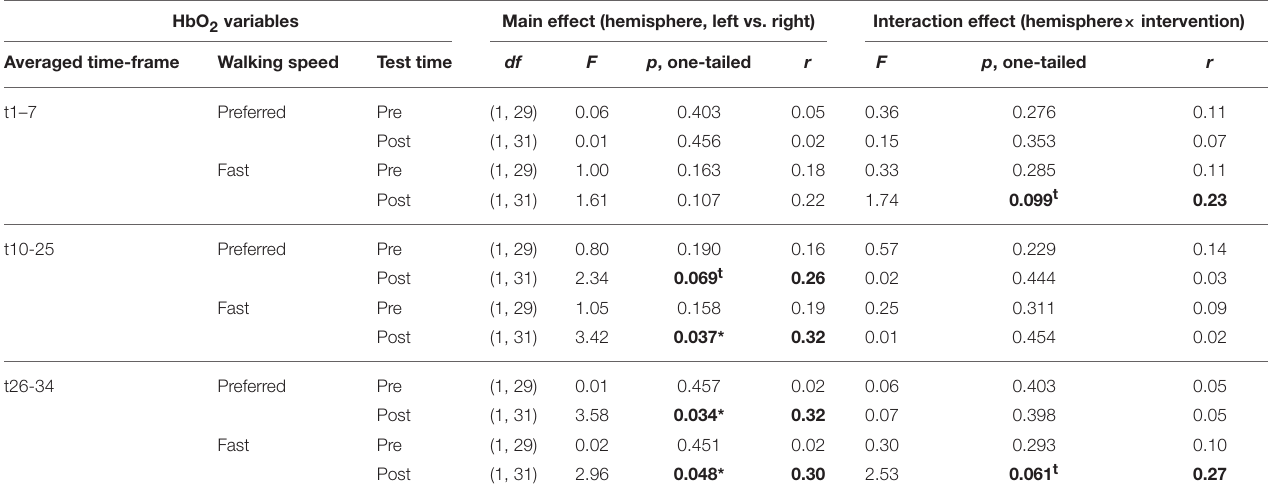
TABLE 3 | Results of repeated measures ANOVA for left vs. right PFC activity. HbO 2 variables Main effect (hemisphere, left vs. right) Interaction effect (hemisphere ×